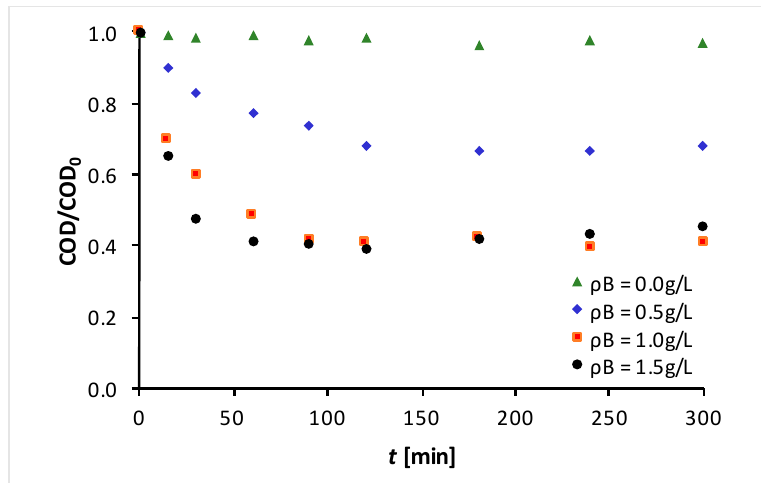
Figure 2. Effect of the catalyst loading on the photodegradation of tanning. The experiments were carried out by fixing the following operation conditions: COD 0 = 200 mg/L, T = 298 K, Q air = 1.0 × 10 − 6 m 3 /s, and v = 500 rpm.